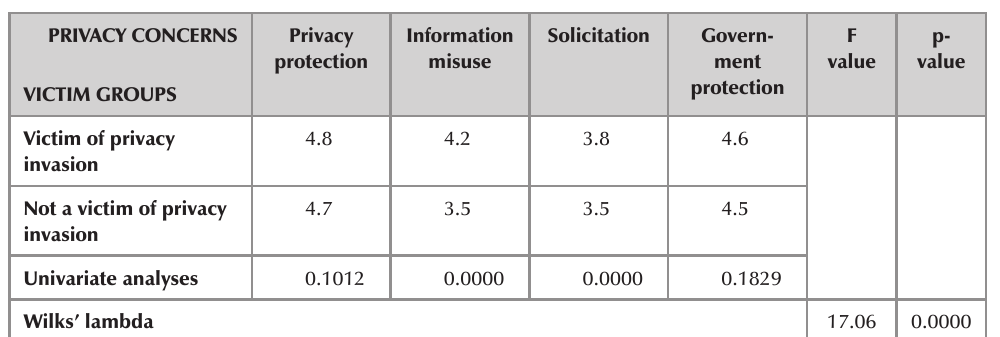
Test results for different privacy victim